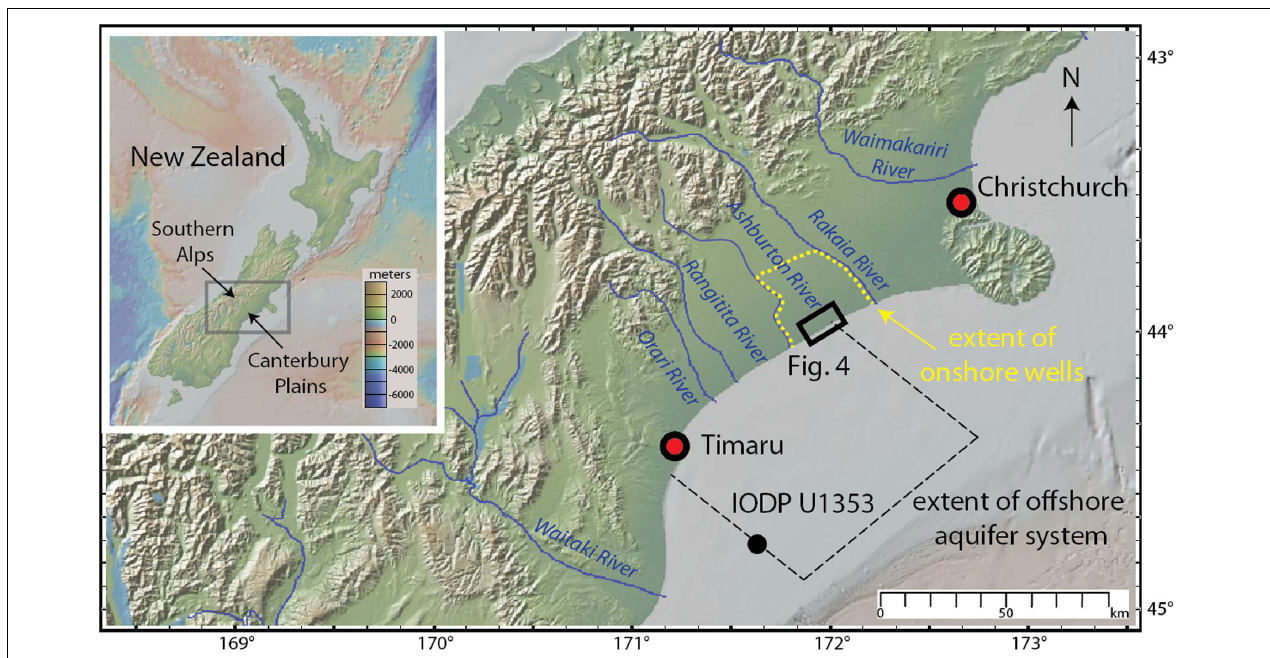
FIGURE 2 | Map of New Zealand, and location of the study area in the Canterbury Plains region of the South Island, New Zealand. The approximate extent of the OFG system is outlined by the black dotted lines and the location of IODP borehole U1353 is shown as a reference. The region of the onshore monitoring wells from Davey (2004) is highlighted by the yellow dotted line. The location of the zoomed in area for the digital elevation model (DEM) in Figure 4 is outlined by the black box. Maps created using GeoMapApp (Ryan et al.,